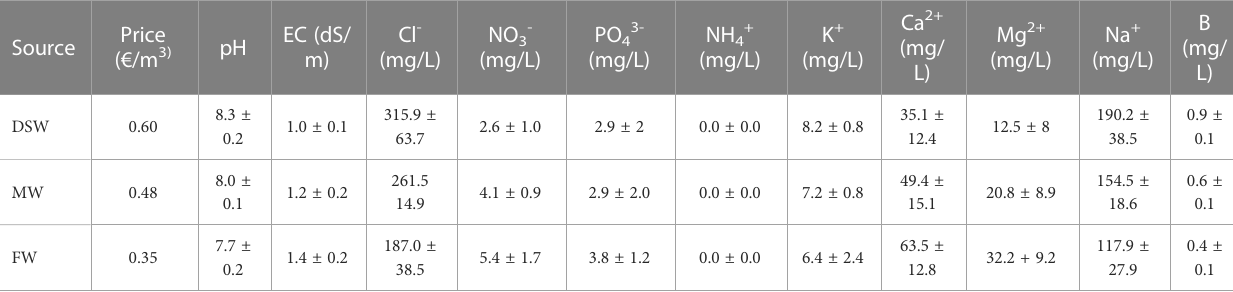
TABLE 1 Average price and values of physical and chemical properties of the water sources used for the trial.